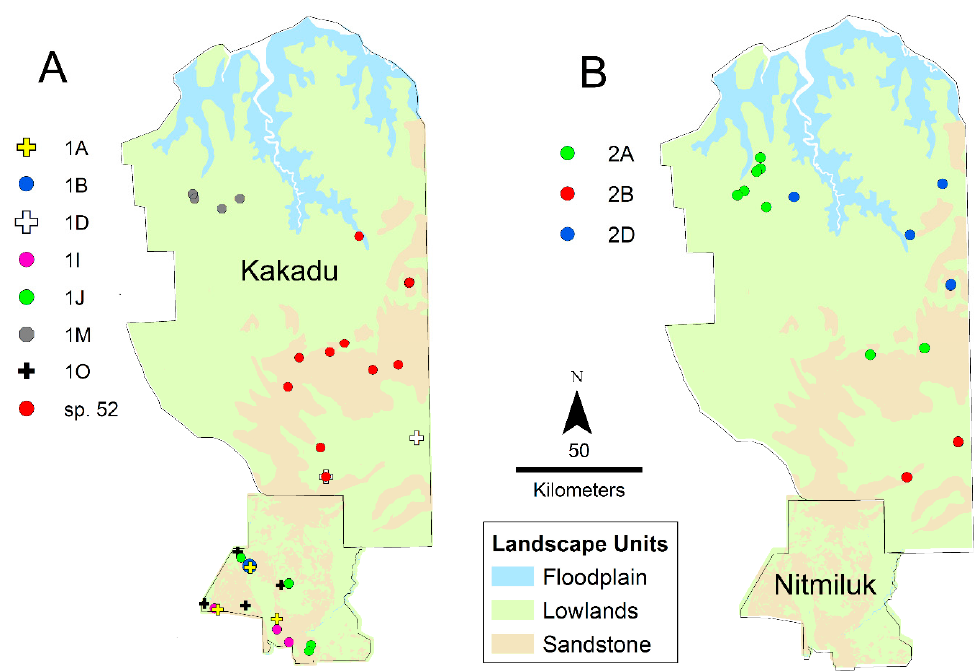
Figure 11. Distribution of species of the sp. 1 ( A ) and sp. 2 ( B ) complexes in Kakadu and Nitmiluk National Parks.